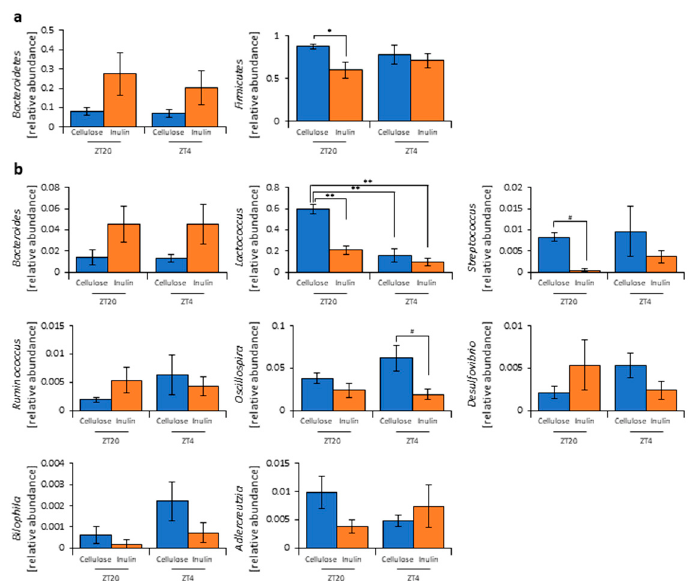
Figure 2. Inulin feeding changed the relative abundance of some bacteria. ( a ) Phylum level. ( b ) Genus level. All values are represented as mean ± SEM (cellulose at ZT20 (n = 5) and 4 (n = 5); inulin at ZT20 (n = 5) and 4 (n = 5)). ** p < 0.01, * p < 0.05, evaluated using the two-way ANOVA with Tukey’s post